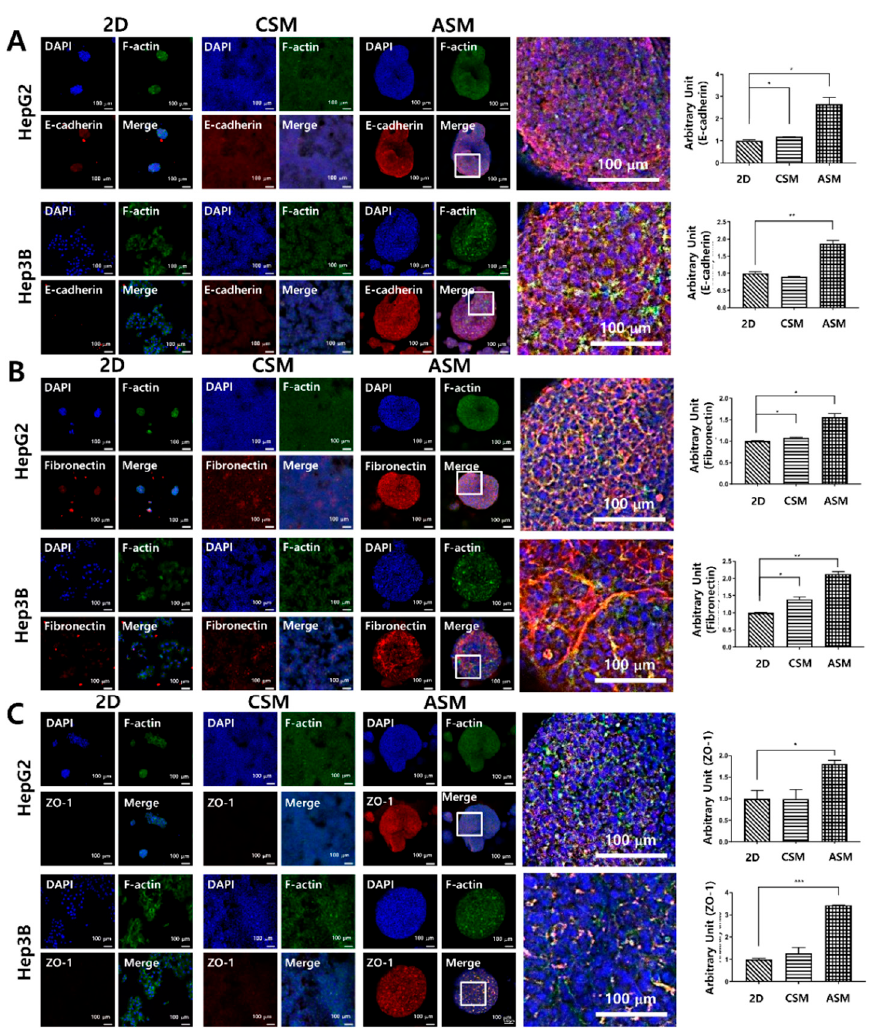
Figure 4. High-content image analysis of epithelial cancer cell protein and drug penetration-related protein expression. The expression of E-cadherin ( A ), Fibronectin ( B ), and ZO-1 ( C ) increased under ASM culture conditions. Optical sections were acquired at 10 µm intervals and stacked into a Z-projection. Scale bars: 100 µm * p < 0.05, ** p < 0.01, *** p < 0.001.